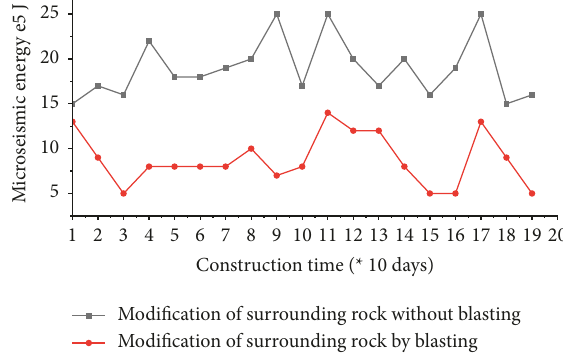
Figure 12: Comparative analysis of microseismic